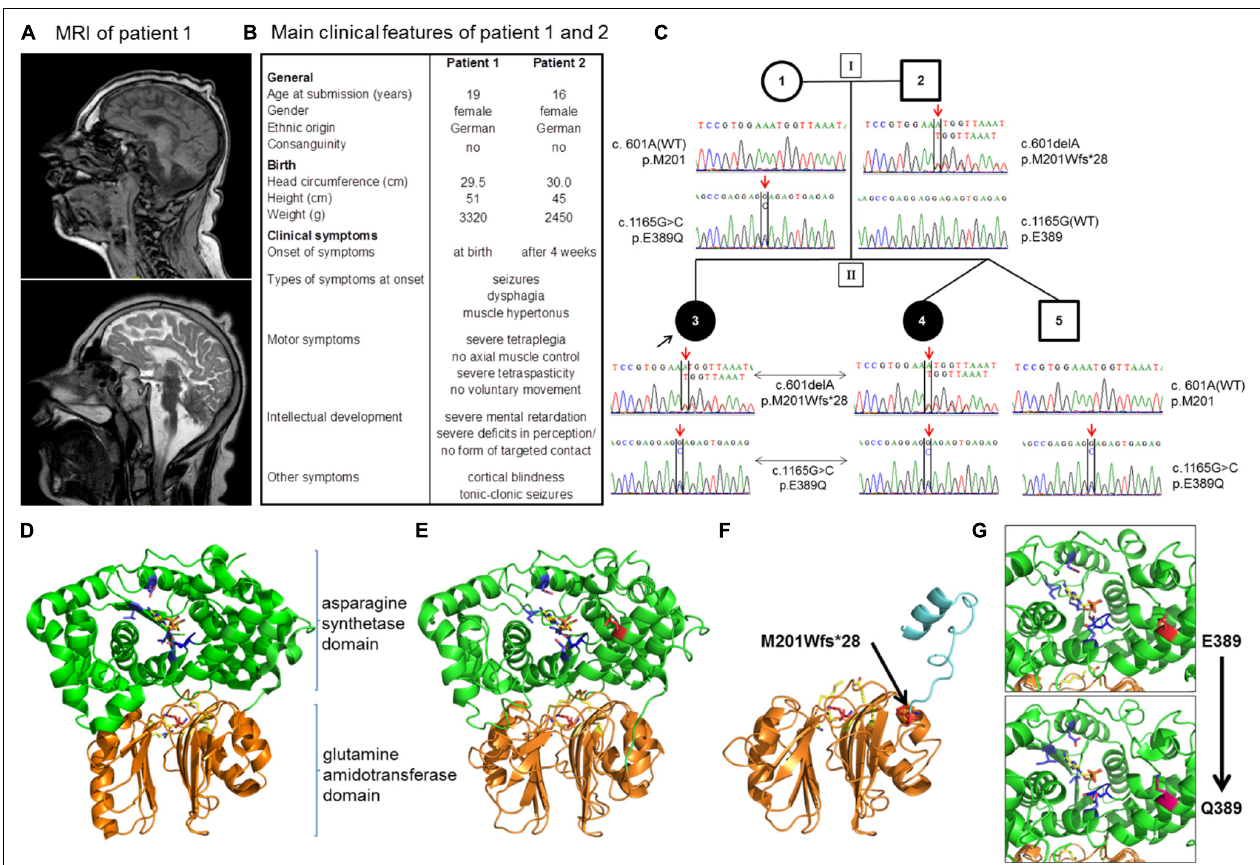
FIGURE 1 | Patients and novel mutations in the ASNS gene. (A) Sagittal MRI images (upper image: T1-weighted, lower-image: T2-weighted) from patient 1 at the age of 10 years demonstrating a severe microcephaly with a pronounced cortical and subcortical atrophy of the cerebral hemispheres. (B) Overview of the main clinical features of patients 1 and 2. Note that disease symptoms are nearly identical in the two patients except for a slightly later onset of the first neurological symptoms in patient 2. (C) Pedigree of the family. Below the symbols the sequencing results of Sanger sequencing spanning the sequence around c.601 and c.1165 for each member of the family are shown. (D–G) Localization of disease mutations in a model of the human asparagine synthetase protein. The human asparagine synthetase protein structure (E,F) were modeled using the asparagine synthetase B crystal structure from E. coli (pdb id: 1CT9) as a template (D) . (D) Structure of E. coli asparagine synthetase B. Orange / lower part of the molecule: glutamine amidotransferase domain with glutamine ( purple ) in the binding pocket (important residues in yellow ); green / upper part of the molecule: asparagine synthetase domain with AMP ( yellow ) in the binding pocket (important residues in blue ). (E) Human asparagine synthetase model visualized until residue 536. The ASNS C-terminus is very flexible and not resolved in the crystal structure of E. coli ASNS B. Important residues for glutamine binding (R49, N75, E77, and D97 in yellow ) and glutamine ( purple ) in the binding pocket are shown in the glutamine amidotransferase domain (conserved). E389 (presented in red ) is the residue for which the heterozygous mutation E389Q was found in the family. (F) Modeling of the M201Wfs ∗ 28 mutation ( red , black arrow ) illustrates the mutant protein lacking the asparagine synthetase domain due to the premature stop codon. (G) Detailed view of the human asparagine synthetase domain with residues E389 ( red ; upper part ) and Q389 ( pink ; lower part